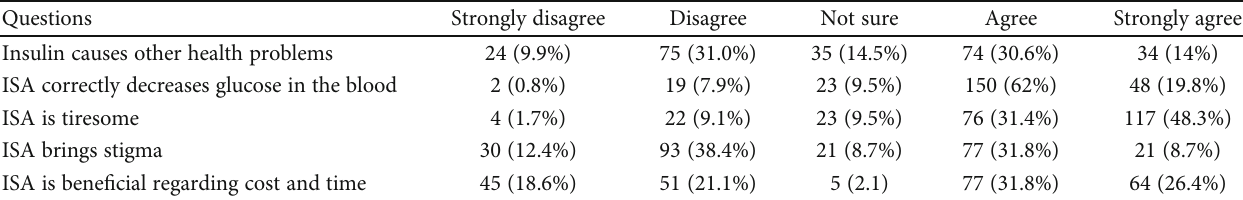
Table 3: Attitude regarding ISA among type 1 diabetic patients at MKRH,